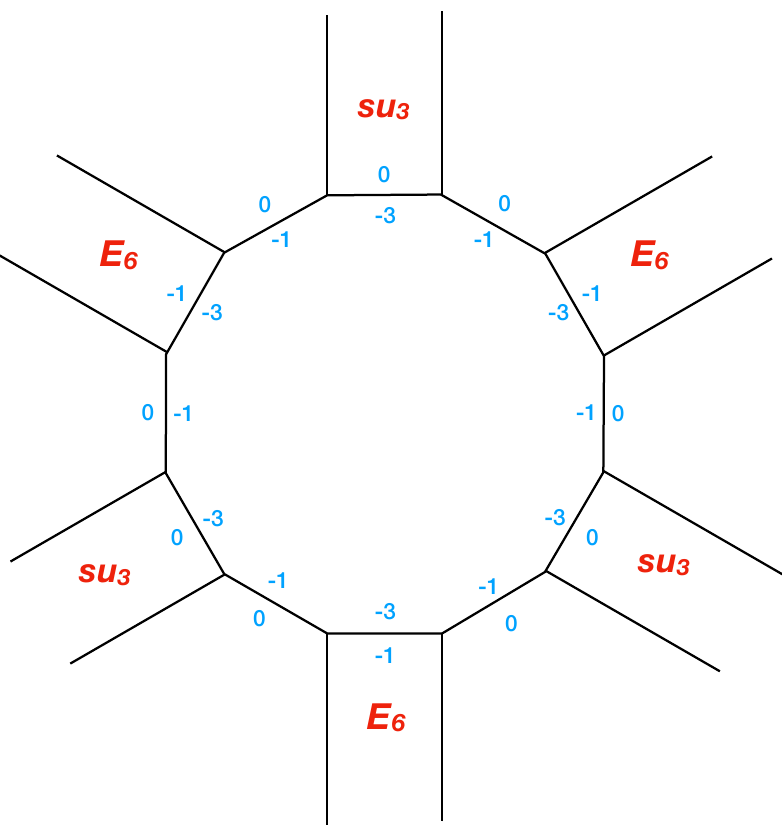
Figure 3 . The fully blown up E 6 { E 6 { E 6 Yukawa